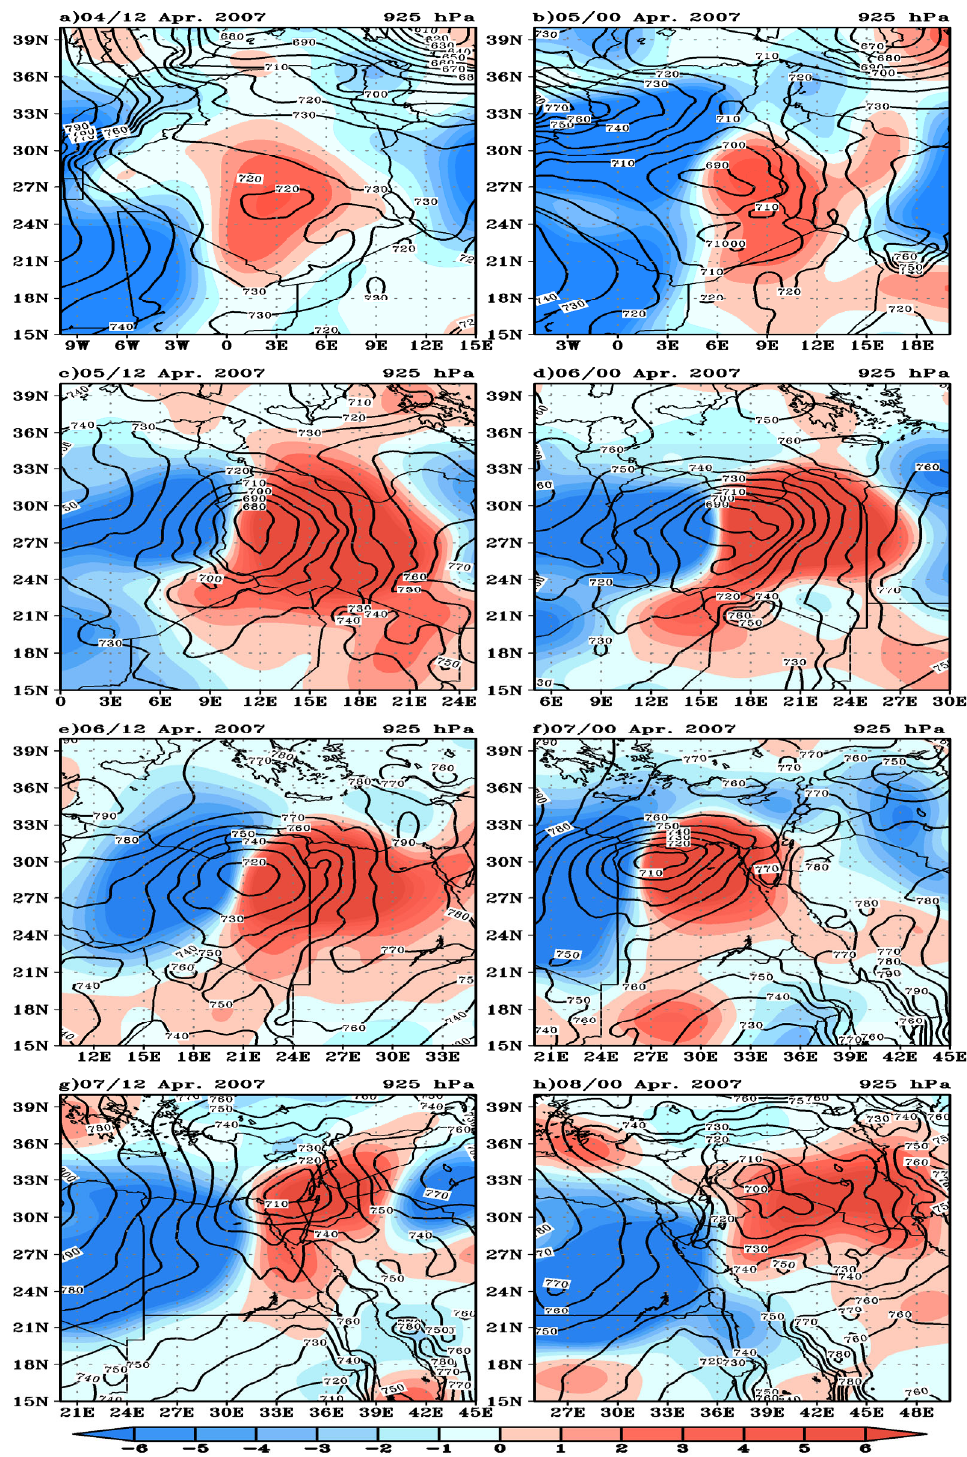
Figure 7. The 925 hPa geopotential height with 10 gpm contour intervals (solid lines) and temperature advection (shaded areas) at 12Z and 00Z for 4–8 April 2007.